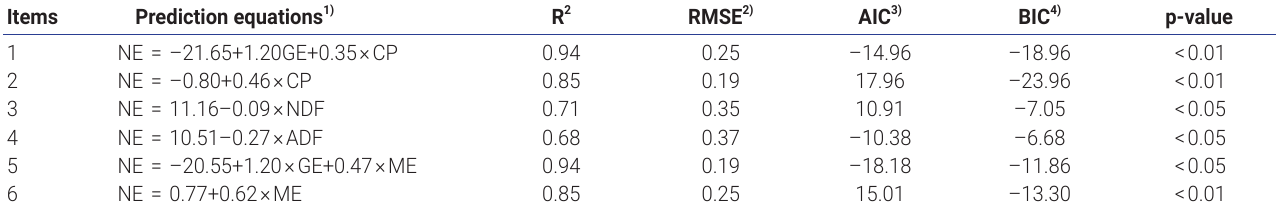
Table 7. Stepwise regression equations for prediction of net energy content of wheat bran fed to growing pigs